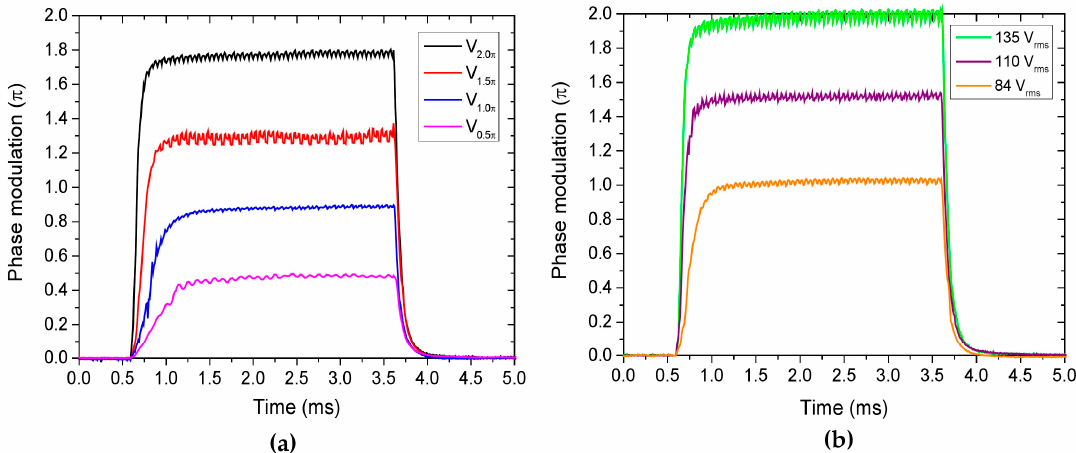
Figure 6. Measurements of response time in the RM8 cell for operating phase modulations: ( a ) Phase modulation voltages according to data in Table 2; ( b ) High phase modulation voltages corresponding to correct phase modulations of 1.0 π , 1.5 π , and 2.0 π .